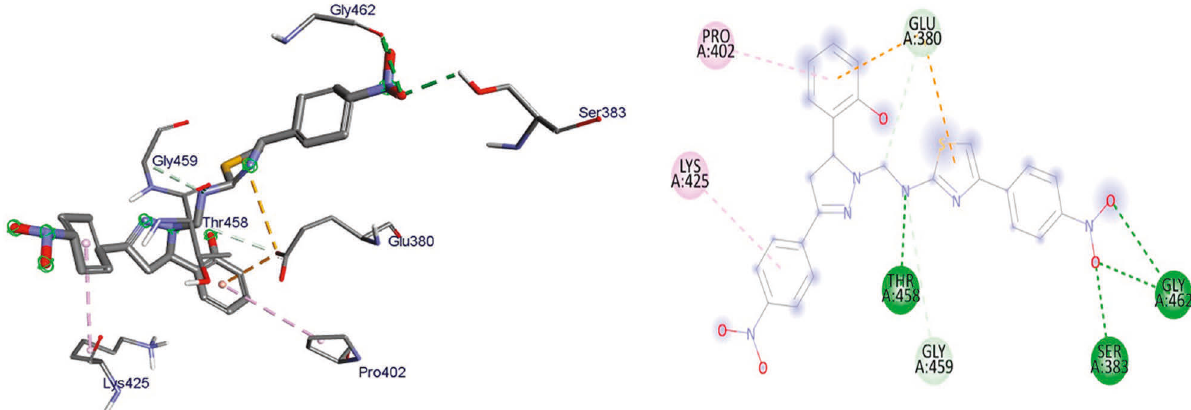
Figure 7: 3D (a) and 2D (b) representations of the binding interactions of 23 against S. aureus pyruvate